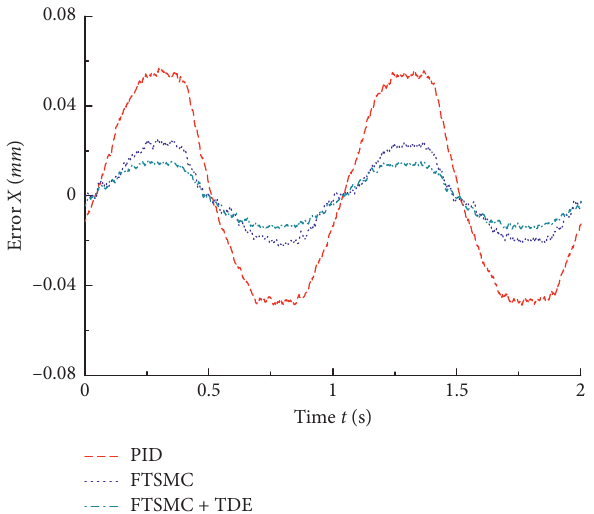
Figure 12: Position error of working condition ⑤ in Table 4.